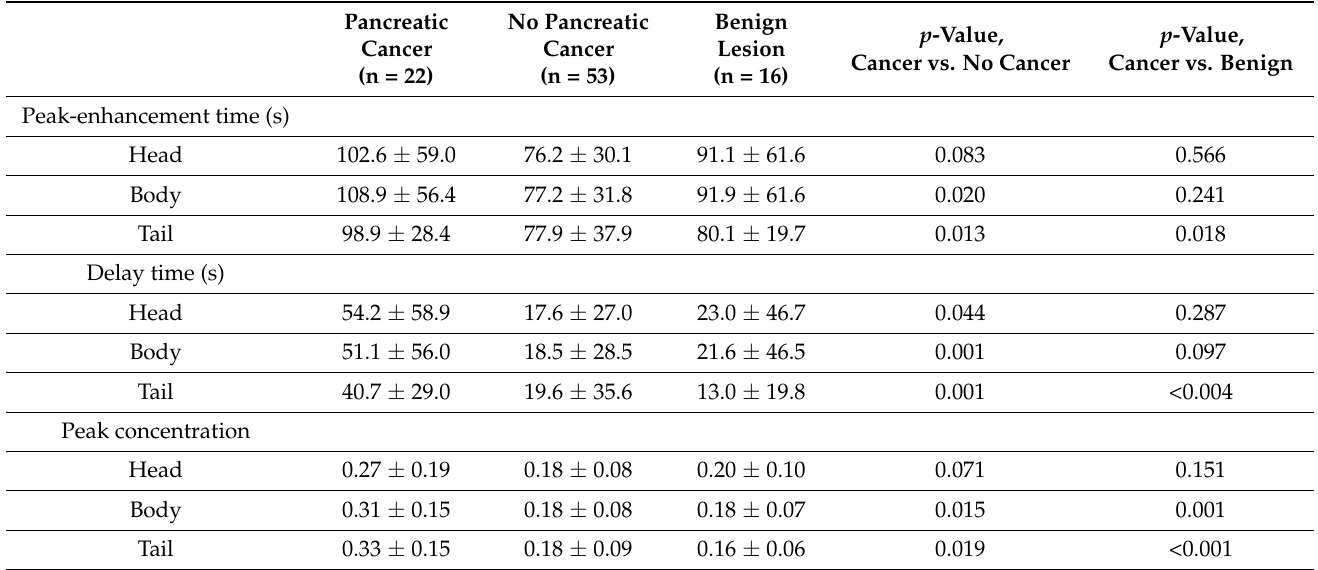
Figure 3. Eighty-nine-year-old female patient undergoing an MRI to evaluate pancreatic focal lesions. Diffuse pancreatic dilatation (arrows) is noted on T2-weighted imaging ( a ), and a 2.5 cm mass suspected to be pancreatic cancer is noted in the pancreatic head (not presented). Dynamic contrast- enhanced curves show gradual enhancement with stable signal intensity in the pancreas head, body, and tail ( b ). Table 5. Differences in enhancement parameters according to presence of pancreatic cancer.